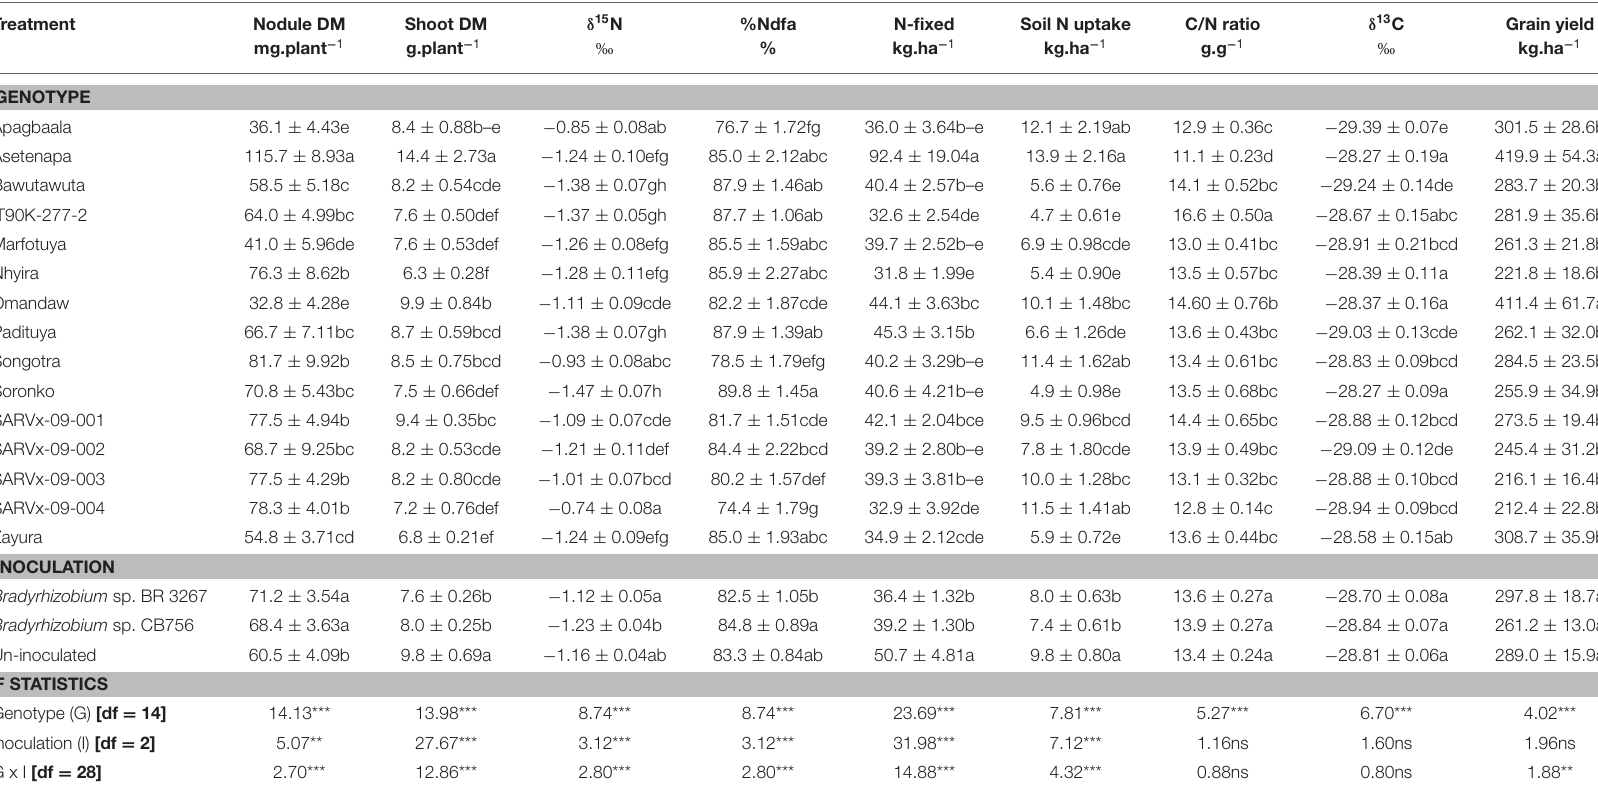
TABLE 2 | Nodulation, shoot dry matter (DM), symbiotic parameters, soil N uptake, δ 13 C, and grain yield of 15 cowpea genotypes inoculated with two Bradyrhizobium strains and planted in Nyankpala in 2013.